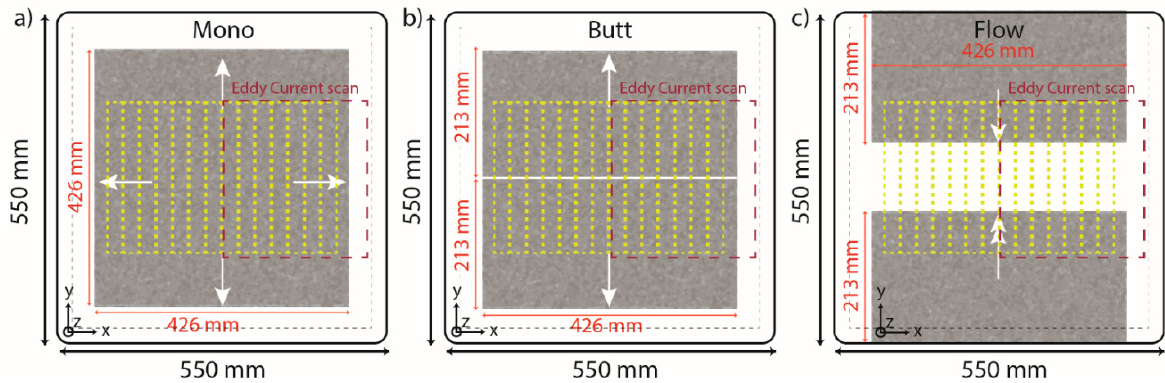
Figure 2. Charge lay-up configuration and mechanical test specimen cutting location in a full flat plaque for ( a ) mono, ( b ) butt, and ( c ) flow . Charge lay-up configuration and mechanical test